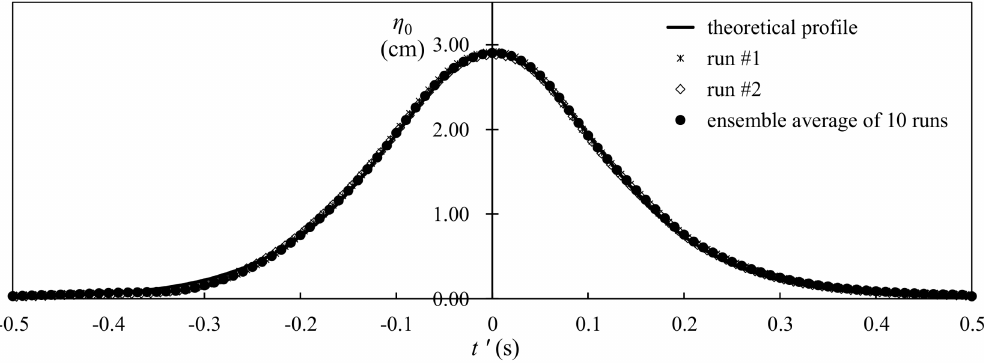
Figure 2. Comparison of temporal variation of free surface elevation measured at x = − 150.0 cm over constant water depth with that predicted by the theory (Case